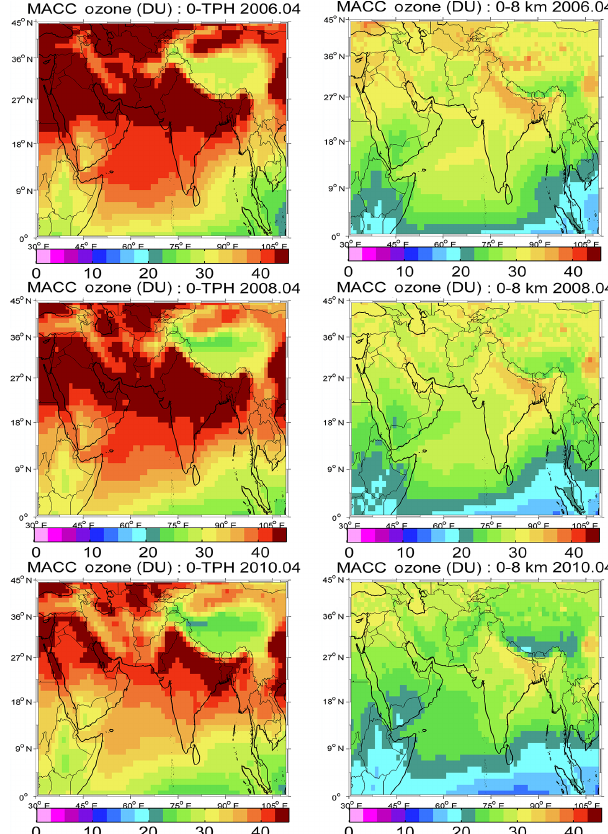
Figure 4. Ozone partial columns (TOC: 0km–TPH ( ∼ 17km over AS) column of tropospheric ozone in the left panels and 0–8km column of tropospheric ozone in the right panels) from MACC re- analysis model in April 2006 (upper panels), 2008 (middle panels) and 2010 (lower